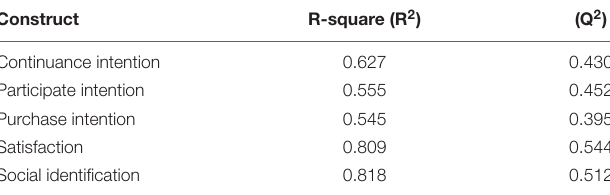
TABLE 4 | Predictive accuracy and relevance of the